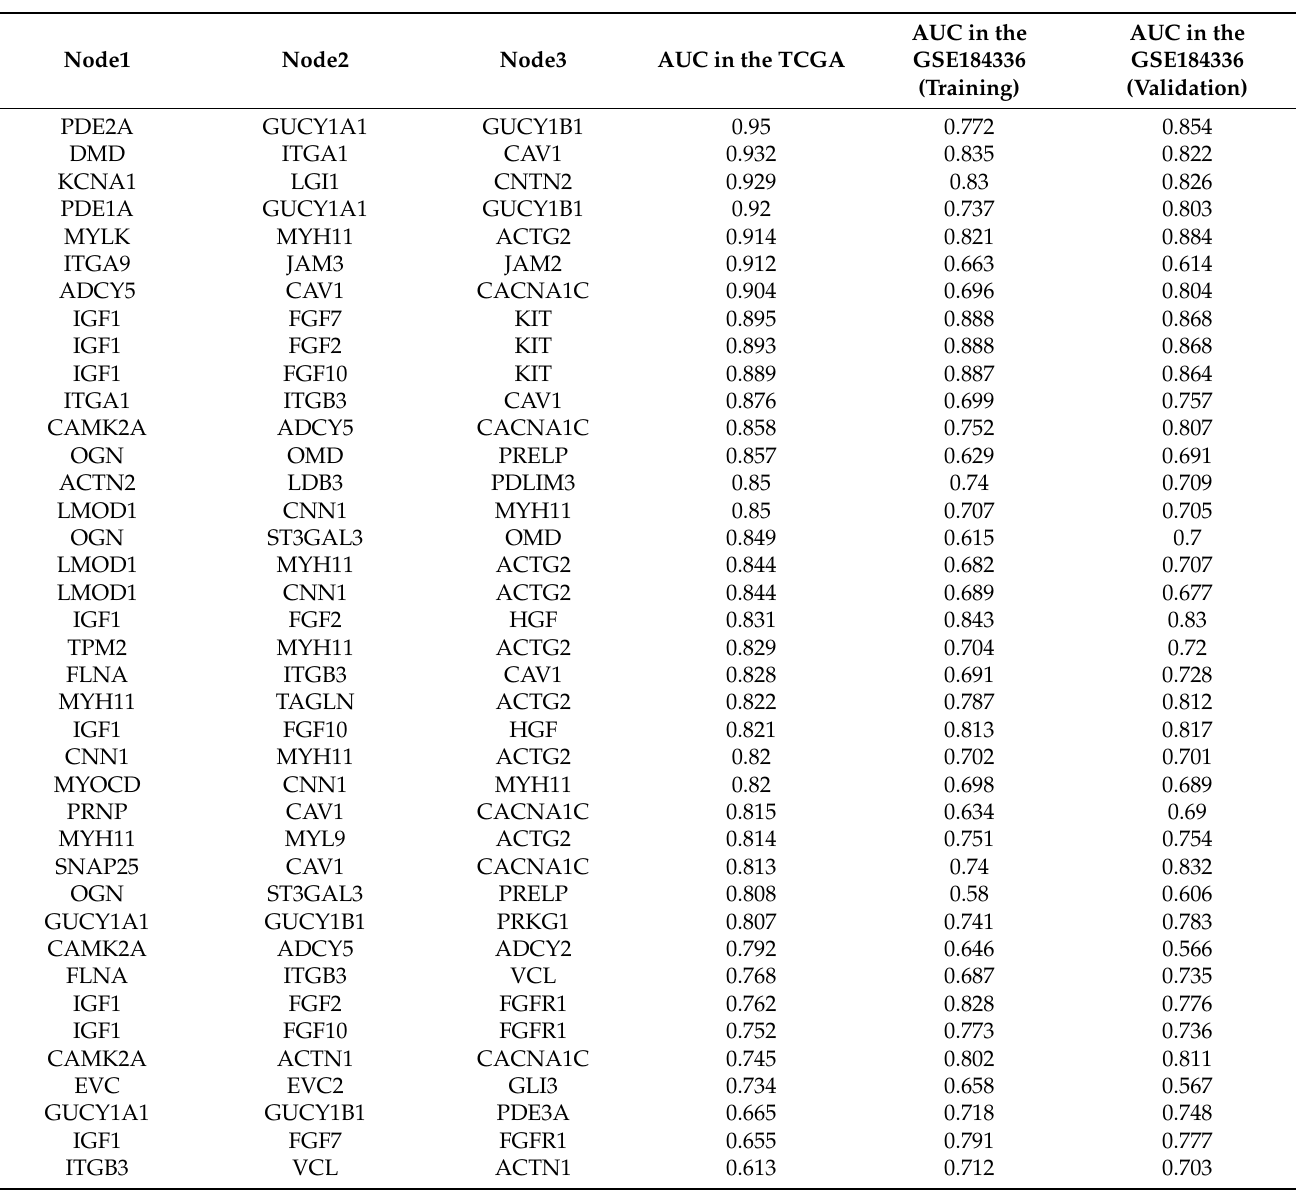
Table 4. The diagnostic capacity of the logistic regression models for distinguishing between the normal and gastric cancer tissues for the 39 top